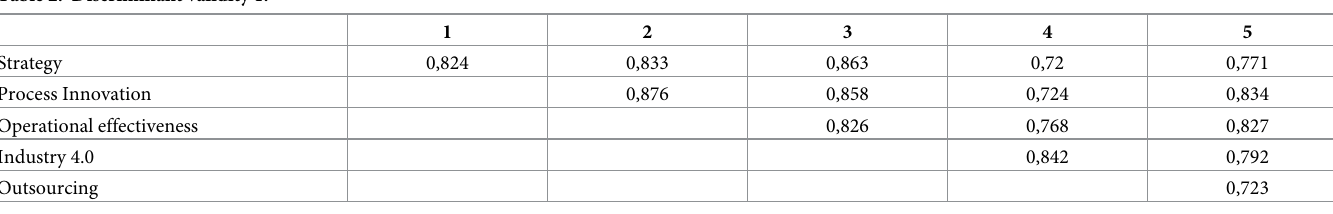
Table 2. Discriminant validity